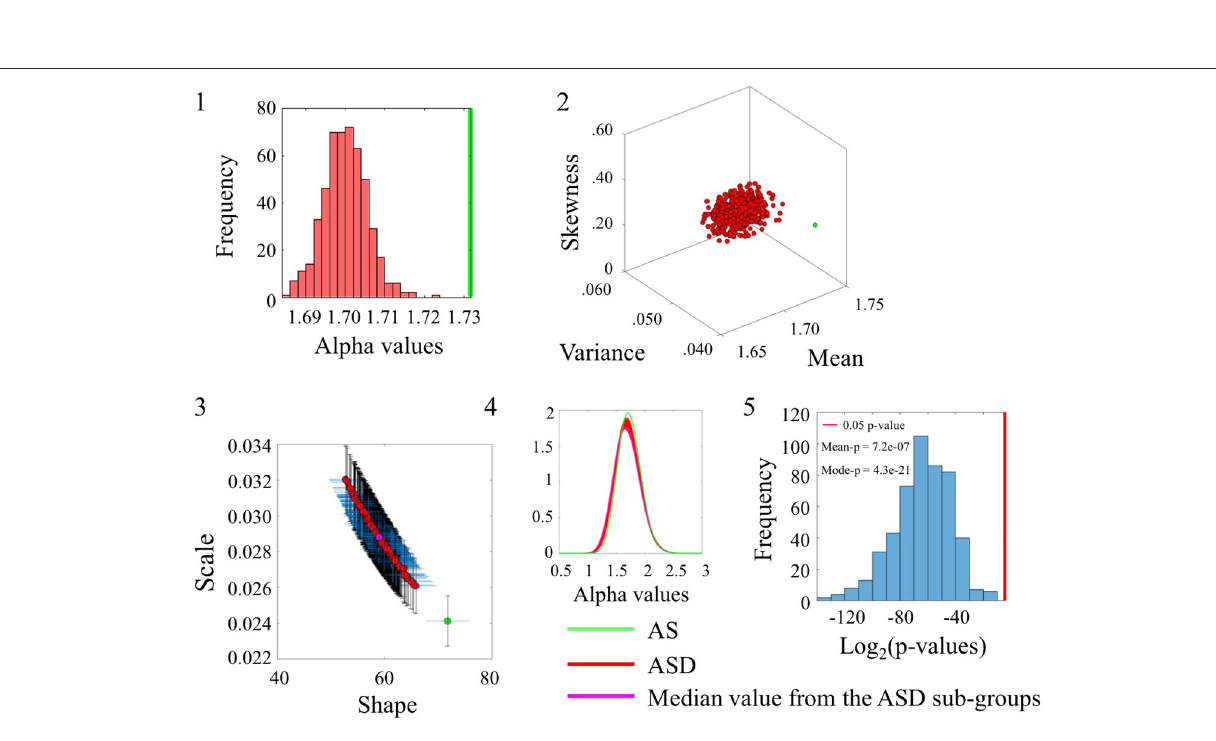
Frontiers in Integrative Neuroscience | www.frontiersin.org